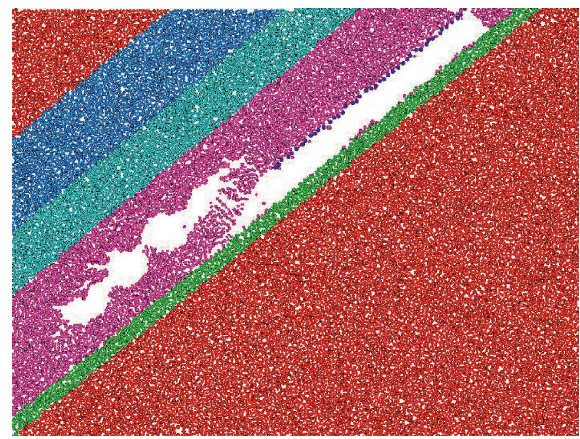
Figure 7: Upward mining and coal caving.